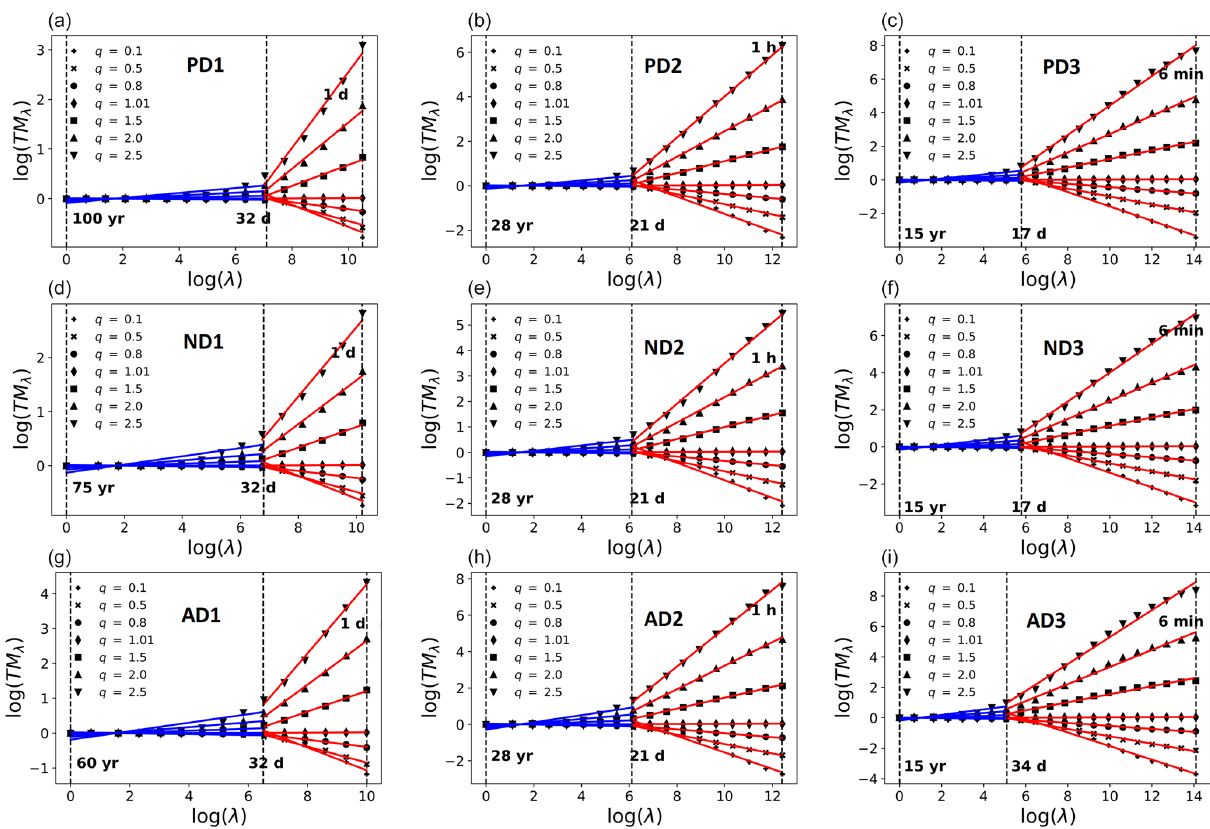
Figure 3. Trace moment analysis of accumulated rainfall data. (a, b, c) Paris: PD1, PD2, PD3; (d, e, f) Nantes: ND1, ND2, ND3; (g, h, i) Aix: AD1, AD2, AD3. The first scaling regime is shown in blue, whereas the second scaling regime is shown in